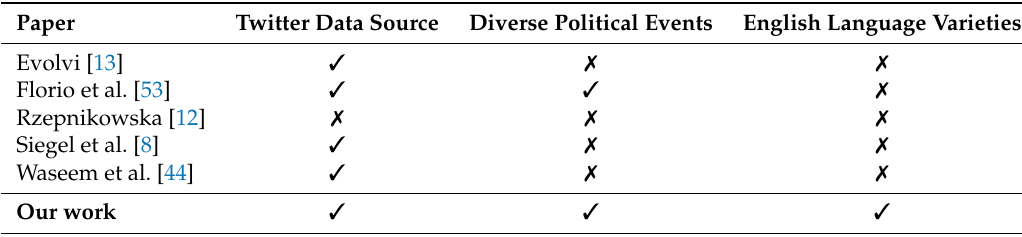
Table 1. Comparison of our work with related literature